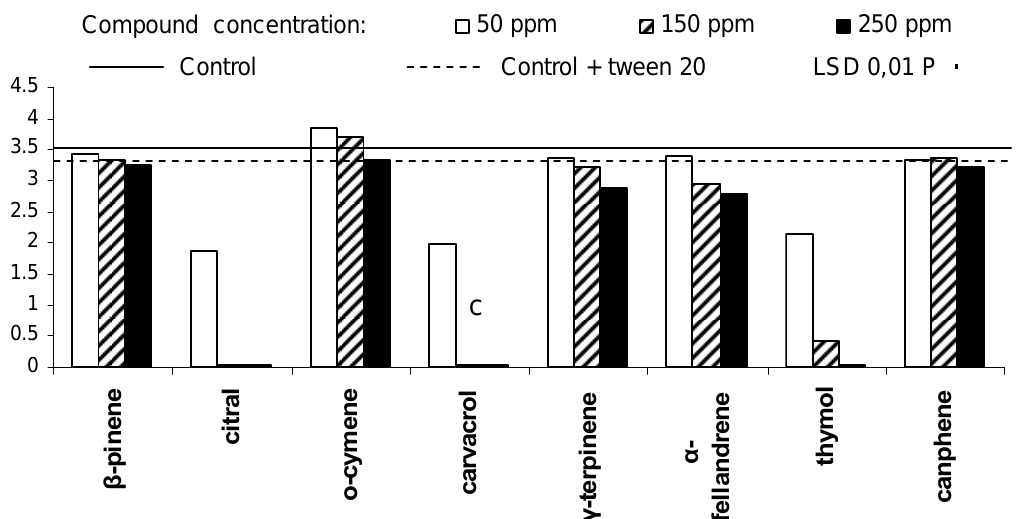
Figure 1. Antifungal activity of the eight plant essential oil components against Phytophthora